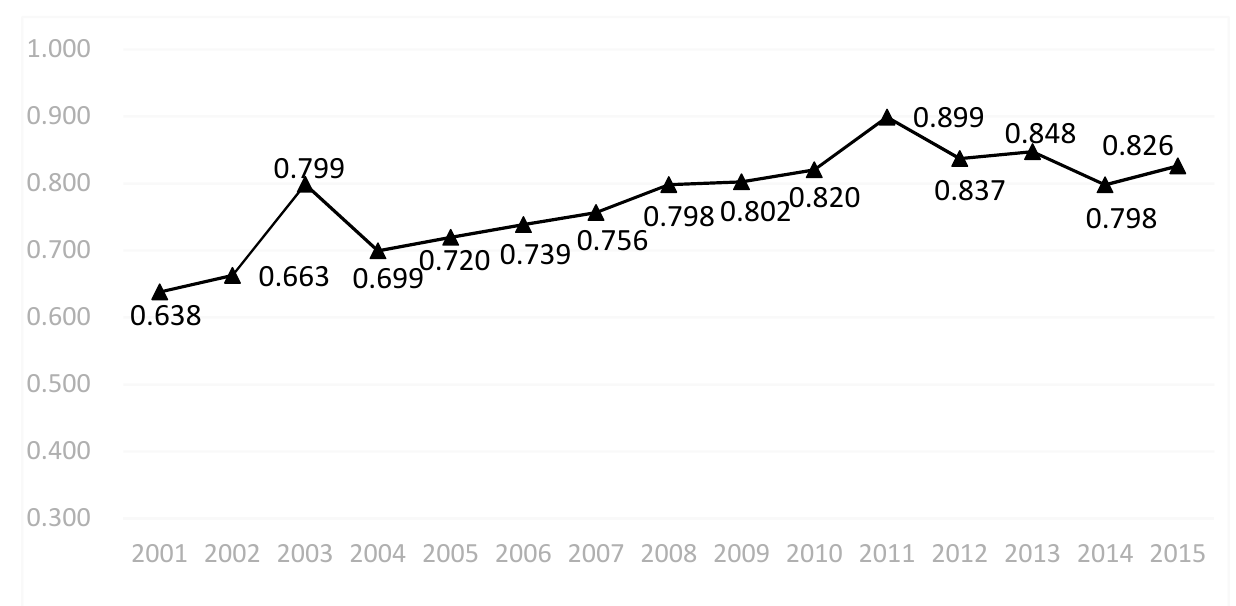
Figure 1. Changes in environmental efficiency of high-polluting industry from 2001 to 2015 in China.